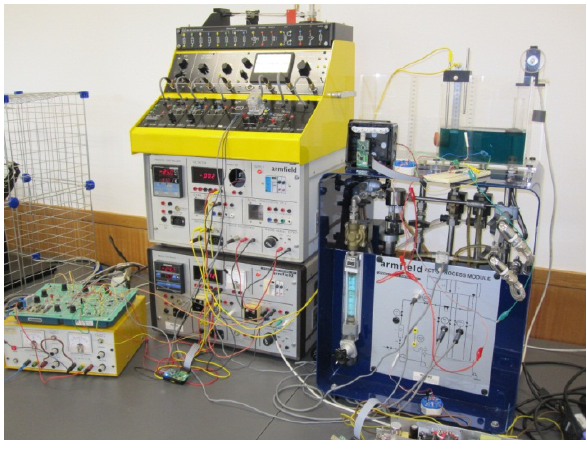
Figure 7. The two-tank process (PCT9) used in Experiment